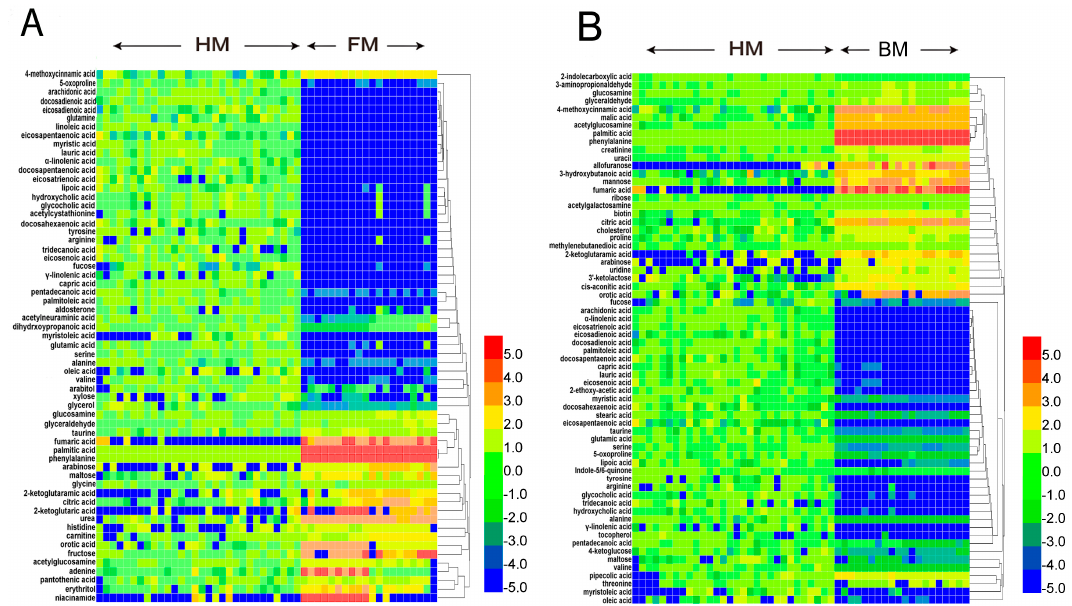
Figure 2. Heatmaps of hierarchical cluster analysis comparing the metabolite changes among HM, FM and BM. The heatmaps were generated using the differential metabolites (variable importance in the projection (VIP) >1, p < 0.05) for the comparison of FM vs. HM ( A ); and BM vs. HM ( B ). The heatmap graphically represents individual changes of ion intensity. The color red represents the relatively higher abundance, and the color blue represents the relatively lower abundance of each metabolite. The fold of change was normalized by log2 transformation. Hierarchical clustering agglomeration was performed on the identified metabolites using the Pearson correlation as the distance metric. HM, human breast milk; FM, formula milk; BM, bovine milk.